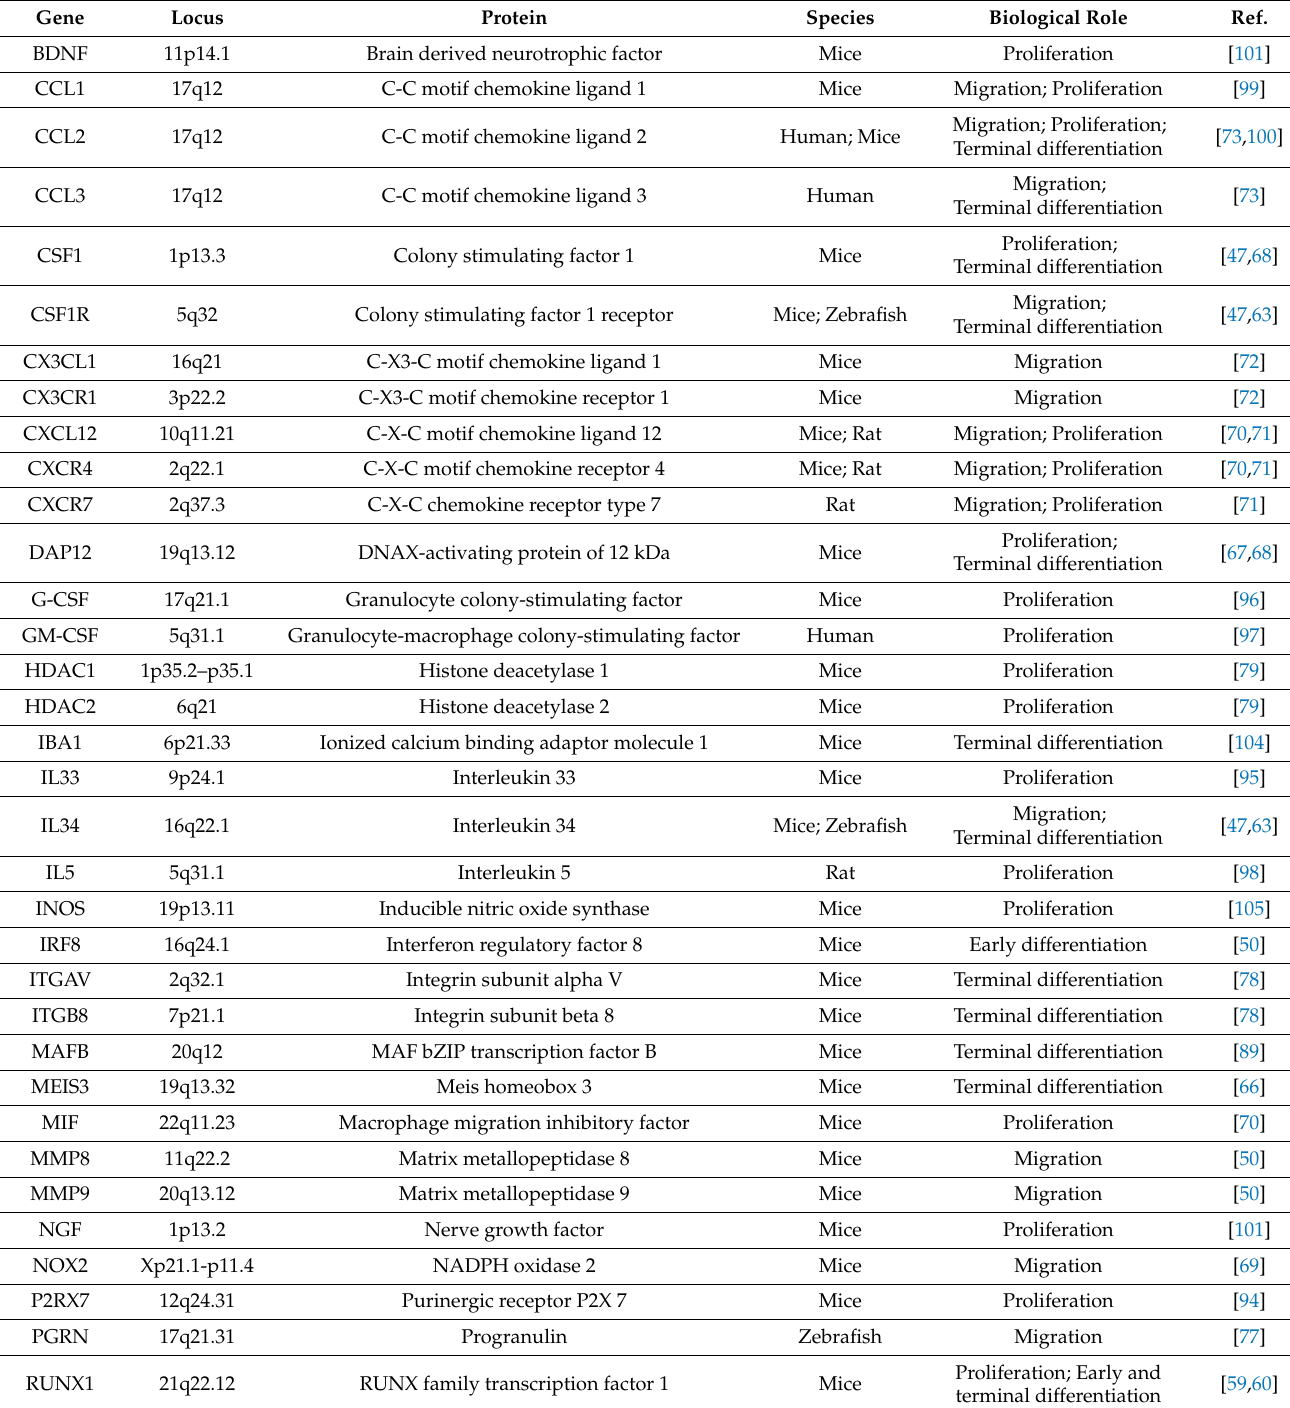
Molecular drivers of microglial early differentiation, migration, proliferation, and terminal